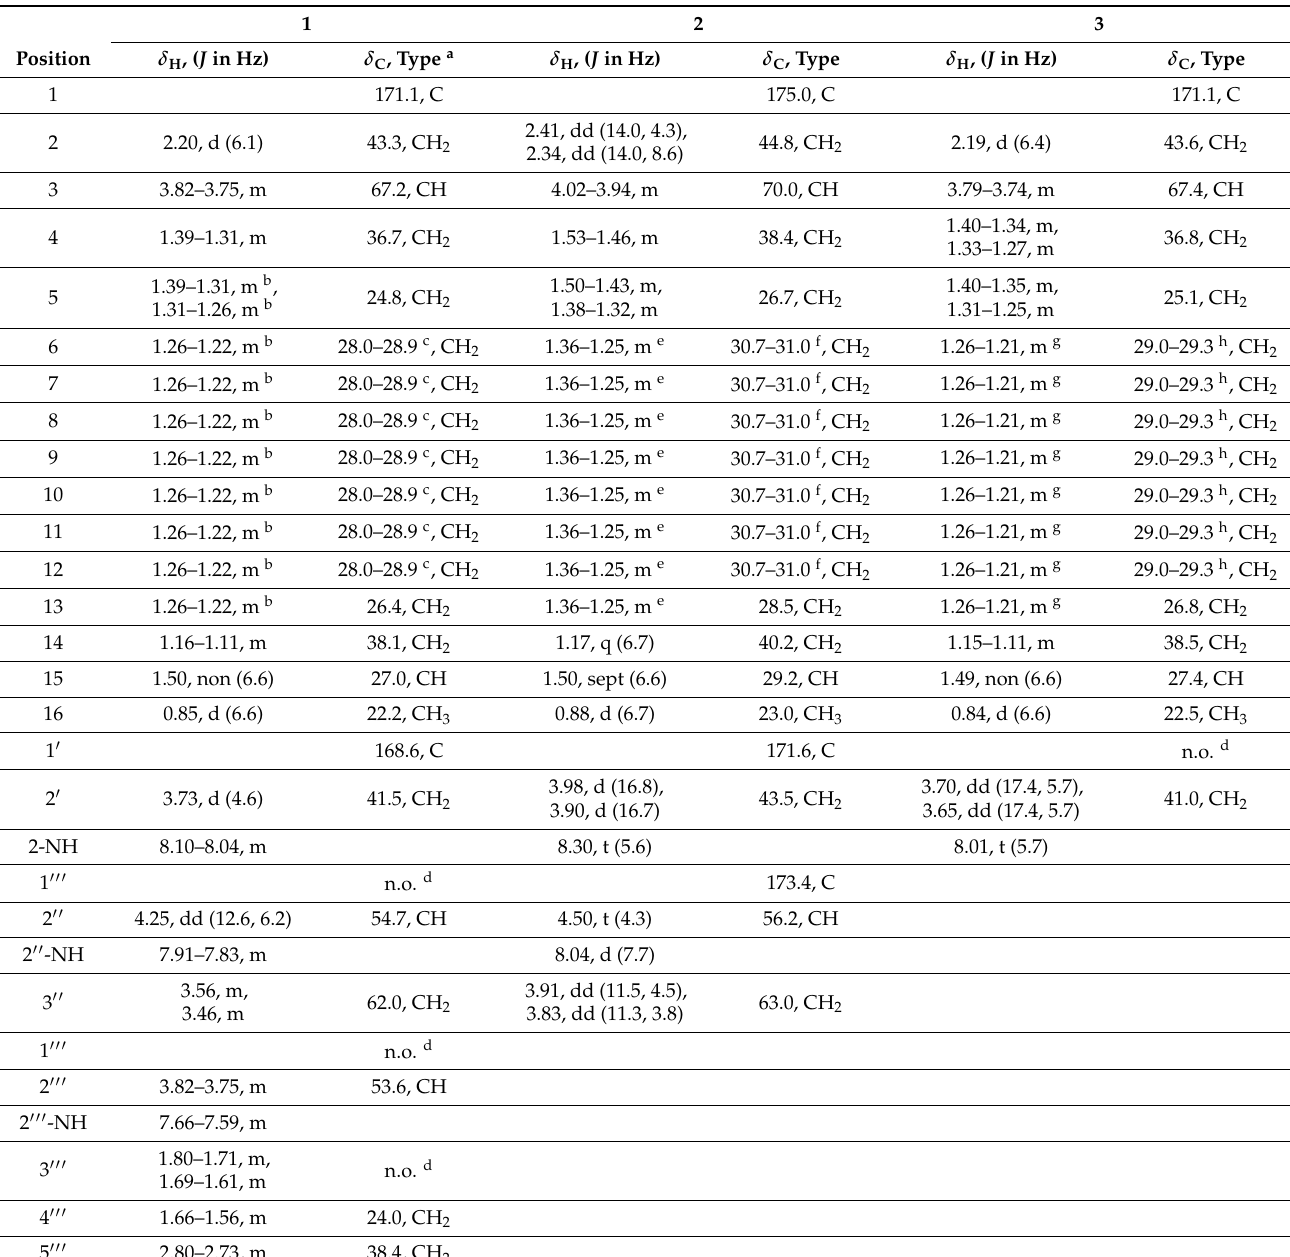
Table 1. 1 H and 13 C data of compounds 1 – 3 ( 1 : 500 MHz/126 MHz, DMSO- d 6 ; 2 : 400 MHz/101 MHz, MeOD- d 4 ; 3: 600 MHz/101 MHz, DMSO- d 6